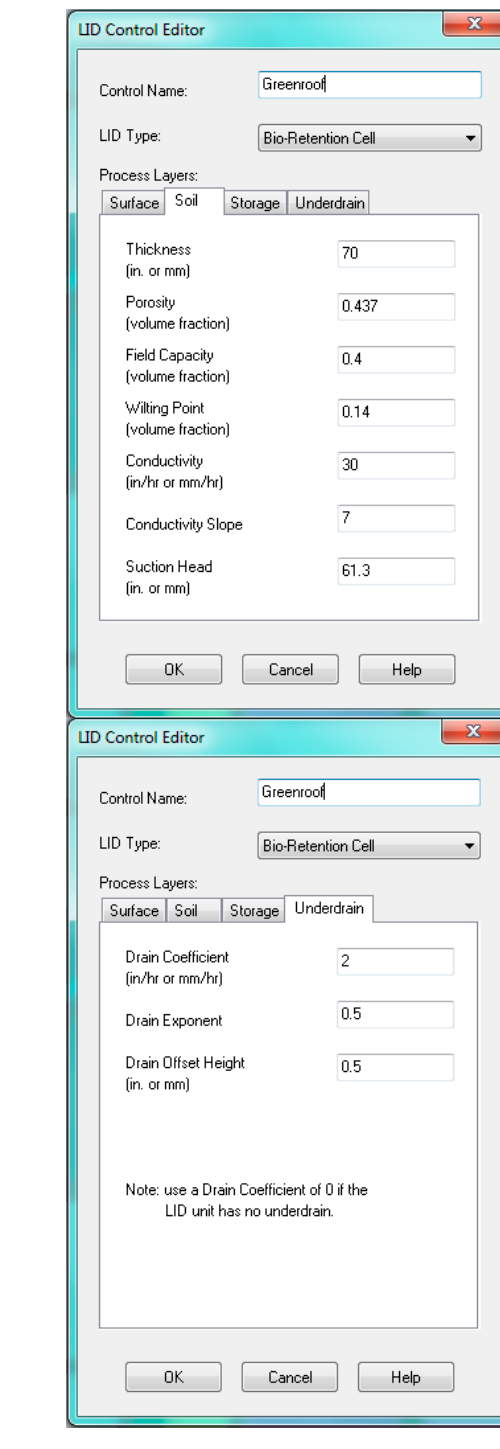
Figure A1. Representation of green roof in SWMM and design parameters used.